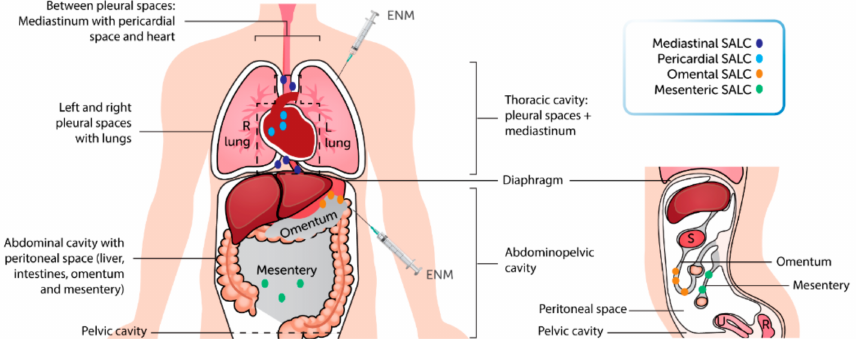
Figure 1. Subdivision of the two coelomic cavities: the thoracic and abdominopelvic cavities. R: rectum; S: stomach; and U: